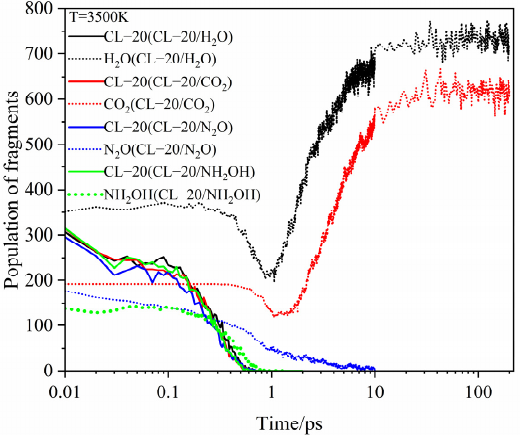
Figure 8. Evolution curves of the host and guest molecules for CL-20/H 2 O, CL-20/CO 2 , CL-20/N 2 O, CL-20/NH 2 OH at 3000 K. Thick trendline corresponds to the actual concentration data of corre- sponding matching color.